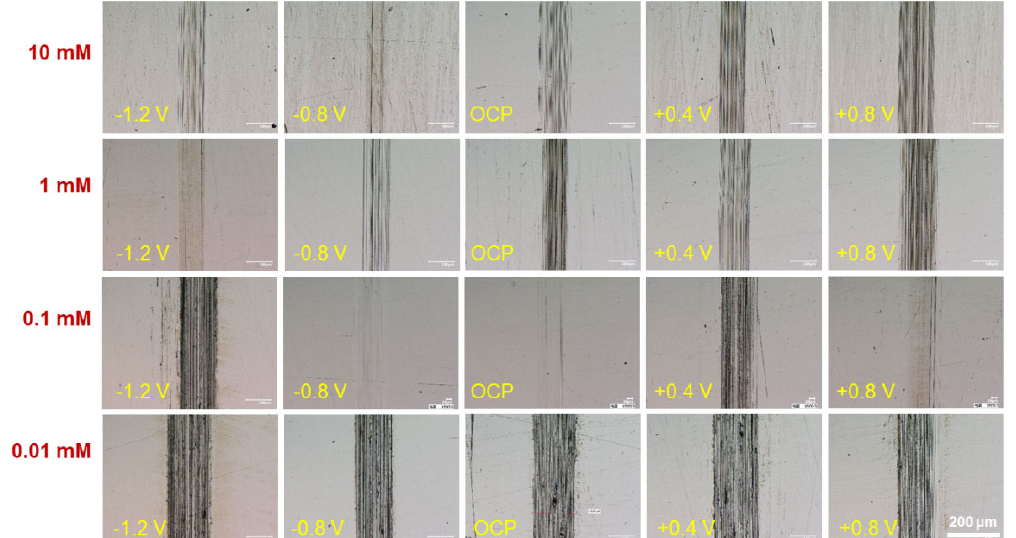
Fig. 3 Surface morphologies of the wear tracks on 304 plate with different SDS aqueous solutions (0.01–10 mM) as lubrication under different applied surface